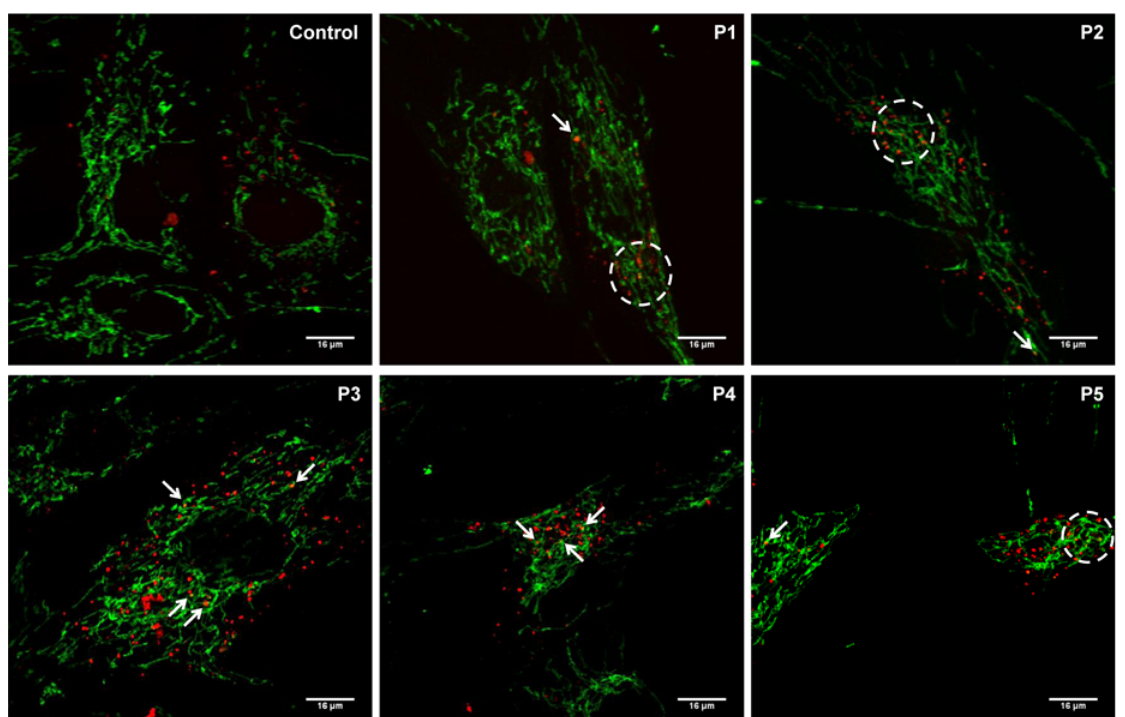
Fig 7. Mitochondrial degradation during autophagy in control and patients´ fibroblasts by immunofluorescence analysis. Cultured fibroblasts were incubated with lysotraker (lysosomal marker; red); inmunostained with anti-cytochrome c (mitochondrial marker; green) and examined in a fluorescence microscope (63X magnifications) as described in Material and Methods. Colocalization of both markers was assessed by Fiji program (Bar = 16 μ